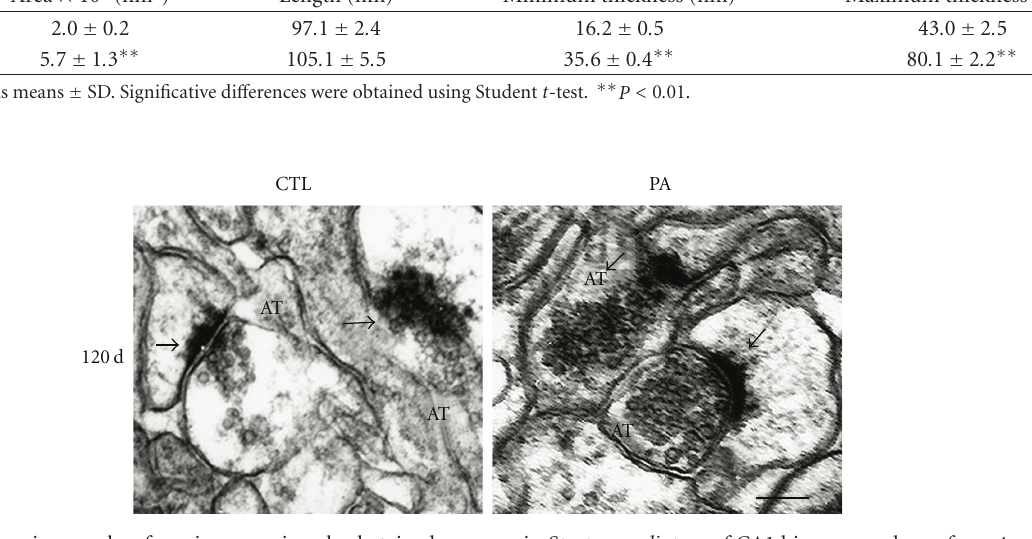
Figure 2: Electron micrographs of osmium-uranium-lead-stained synapses in Stratum radiatum of CA1 hippocampal area from 4-month- old control rats and rats subjected to PA. The synapses (arrows) were intact, and no obvious alterations were seen in these osmium-uranium- lead-stained synapses after PA. AT: axon terminal. Scale bar: 0.5 μ m.